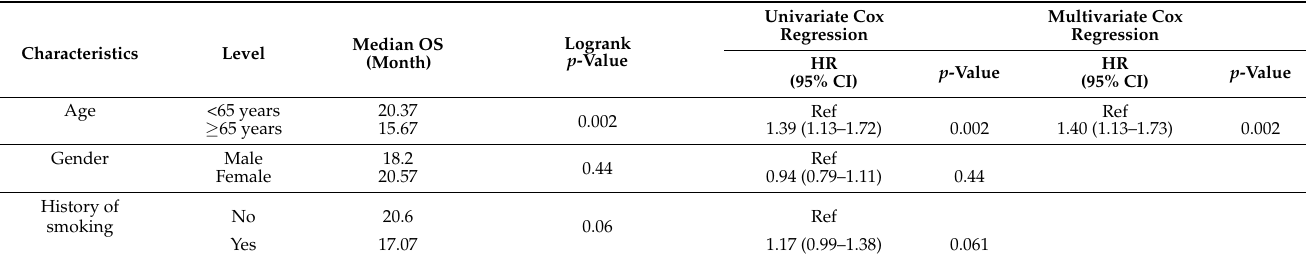
Table 2. Prognostic analysis for patients with lung cancer